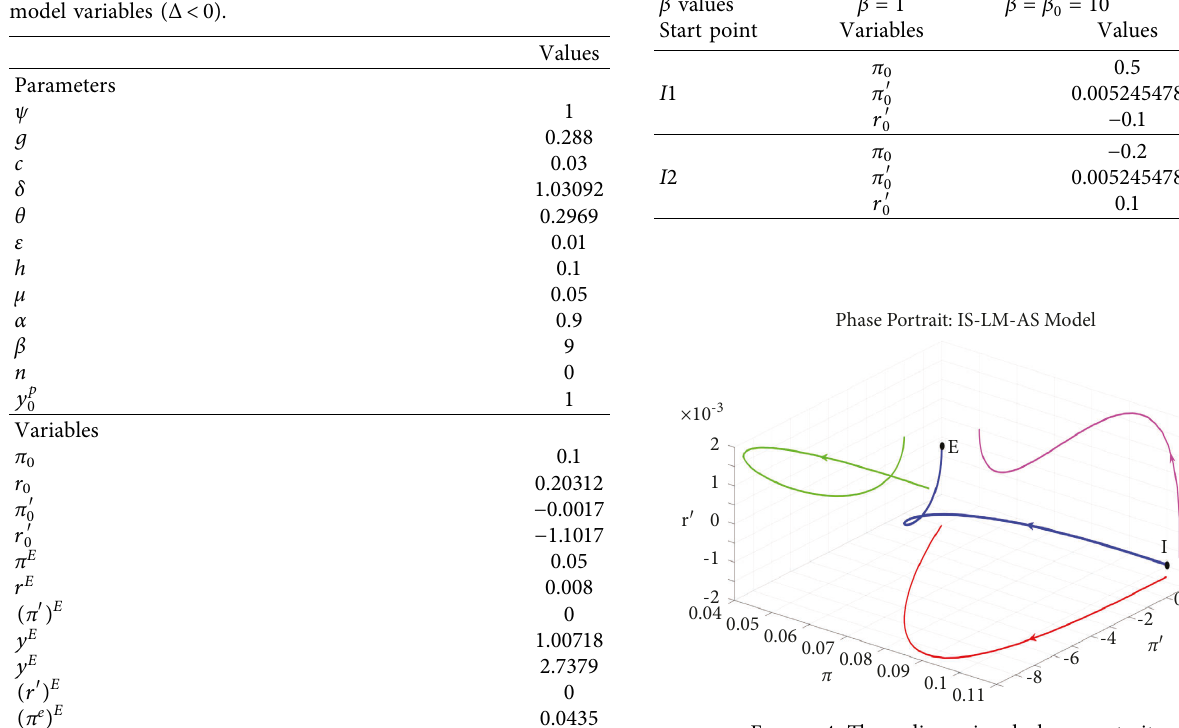
Table 3: Parameter values and initial and equilibrium values of the